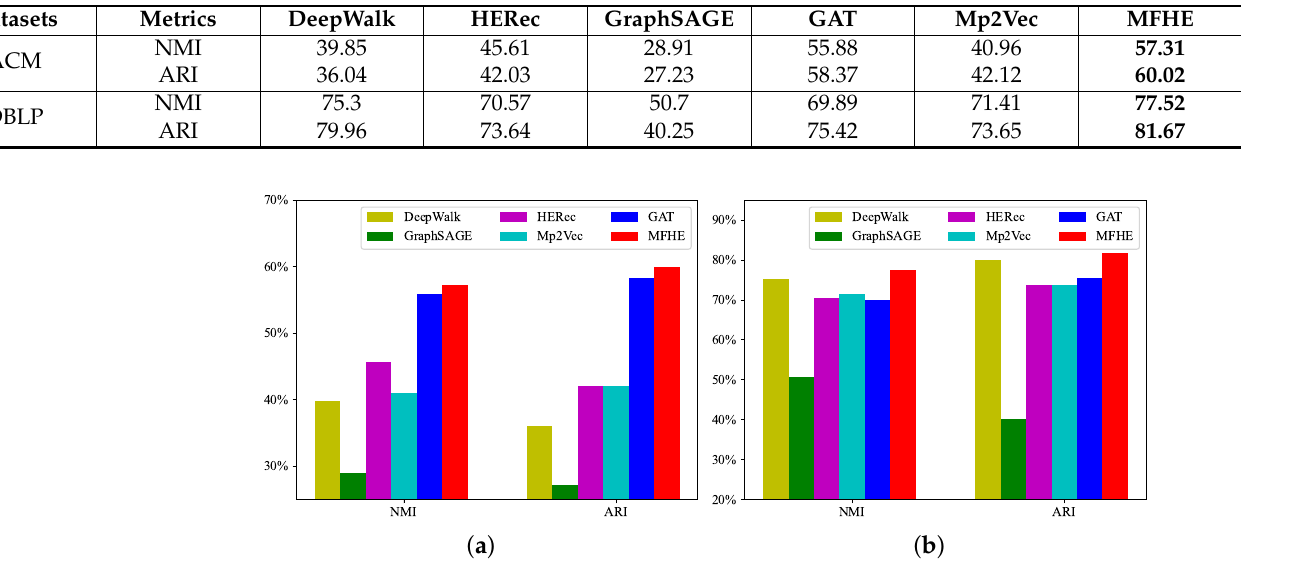
Figure 7. Node clustering results on the ACM and DBLP datasets. ( a ) ACM. ( b )